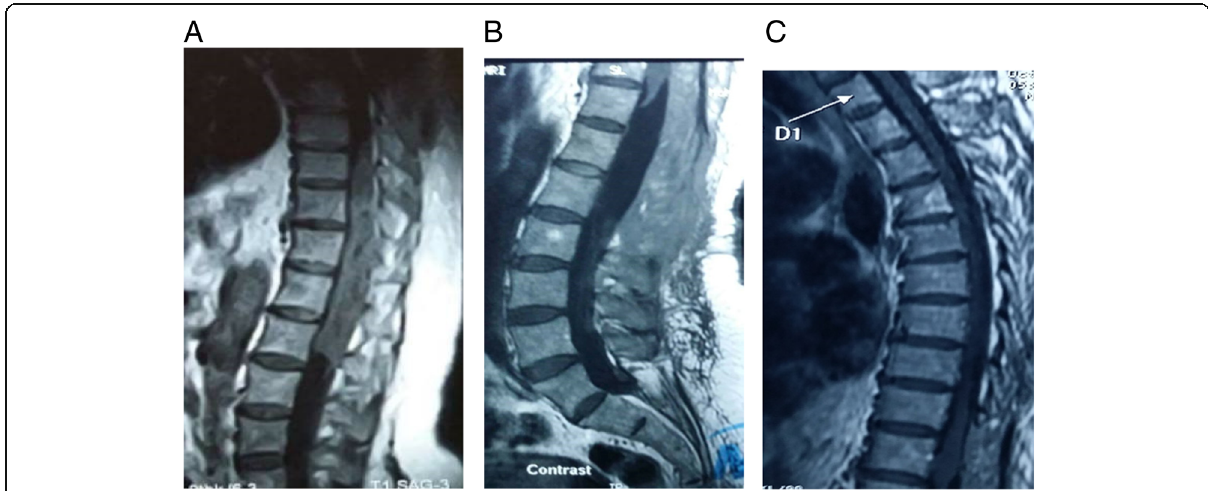
Fig. 2 Male patient, 32 years old, presented with low back pain, bilateral sciatic pain, and paraesthesia with attacks of severe claudication pain and perianal hypoesthesia. Image a MRI-T1W sagittal image showing hyper-intense contrast IMSCT (conus lesion). Images b and c Post-op MRI- T1W sagittal image showing total resection of myxopapillary ependymoma